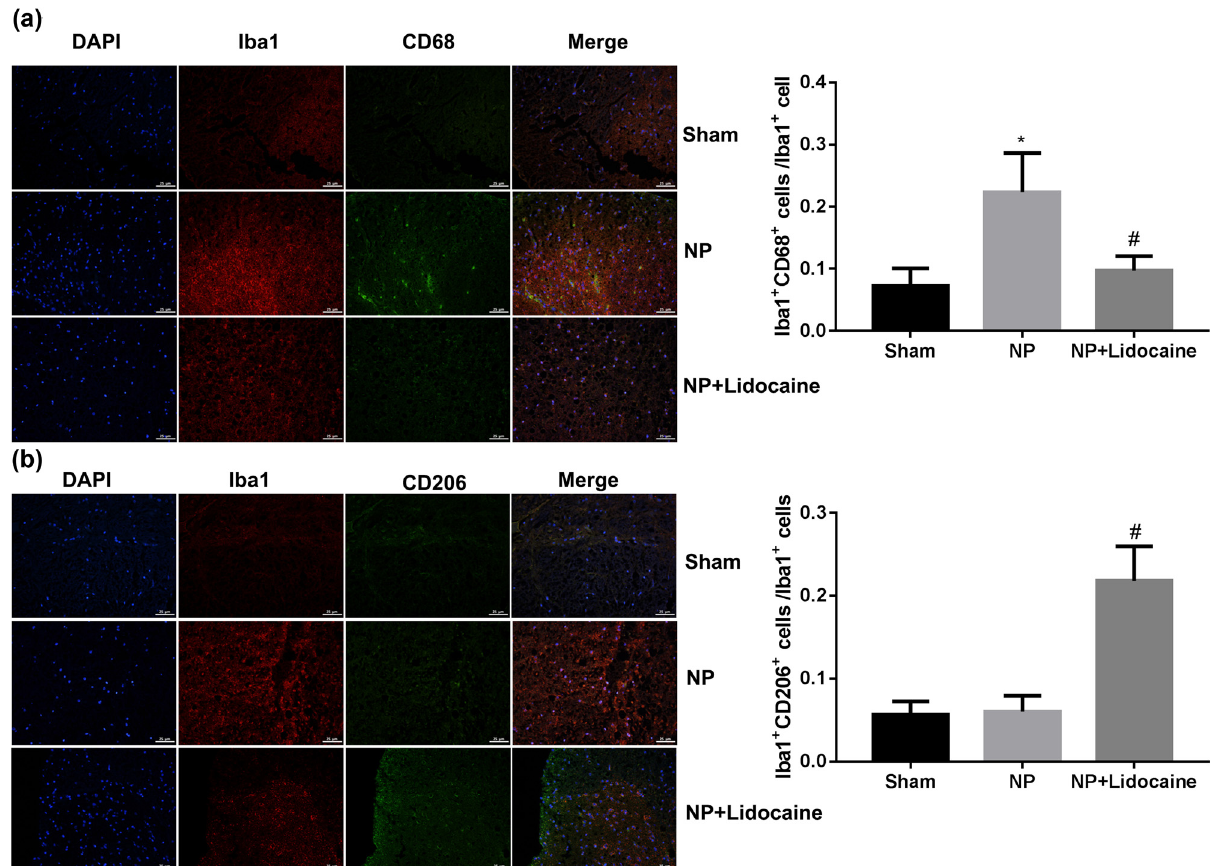
Figure 2: Lidocaine regulated M1/M2 microglial polarization in a rat model of CCI - induced NP. The rats in di ff erent groups were sacri fi ced at 14 days, and L4 – L6 segments of the rat spinal cord were separated. Representative images of immuno fl uorescence assay were used to detect the microglia marker Iba1, M1 marker CD68, and M2 marker CD206 to quantify the number of M1 ( a ) and M2 microglia ( b ) . DAPI ( nuclei, blue ) , total microglia ( Iba - 1, red ) , M1 - microglia phenotype ( CD68, green ) , and M2 - microglia phenotype ( CD206, green ) . Data are expressed as mean ± SD and were analyzed using one - way ANOVA with Tukey ’ s post hoc test. * p < 0.05 versus Sham group; # p < 0.05 versus NP